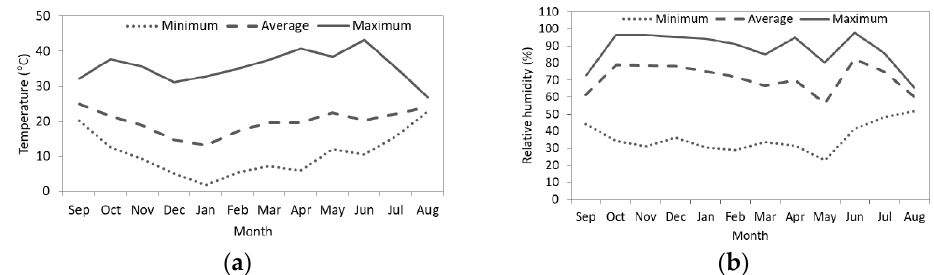
Figure 1. Temperature ( a ) and relative humidity ( b ) recorded during the production of Pinus engelmannii from September 2015 to June 2016.